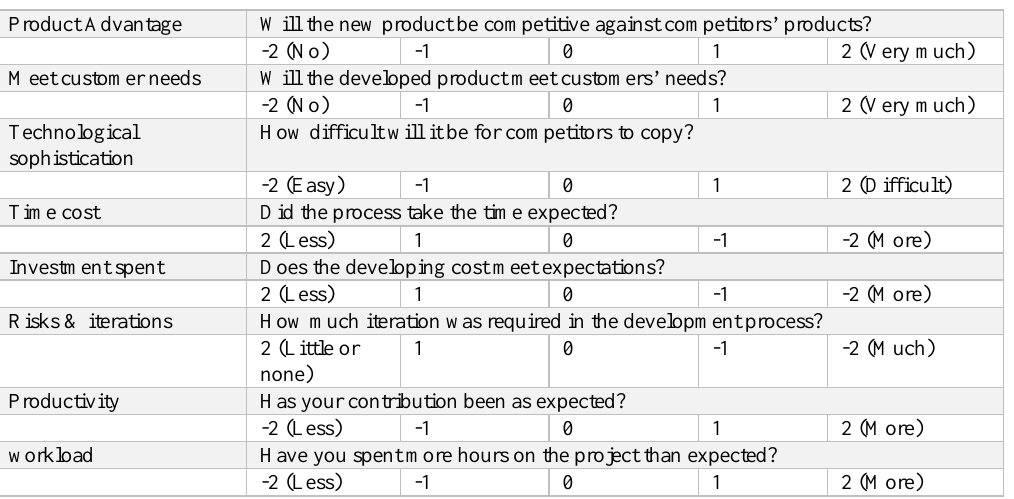
Table 3: Questionnaire as Metrics Tool for Understanding the Effectiveness of Two